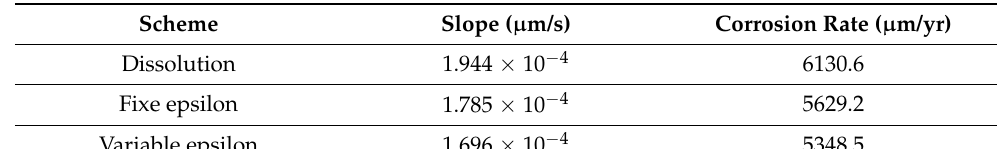
Table 2. Extrapolation of the curves in Figure 7a to determine the dissolution kinetics of the lead surface immersed in 1000 mol/m 3 of HCl for 18,000 s.